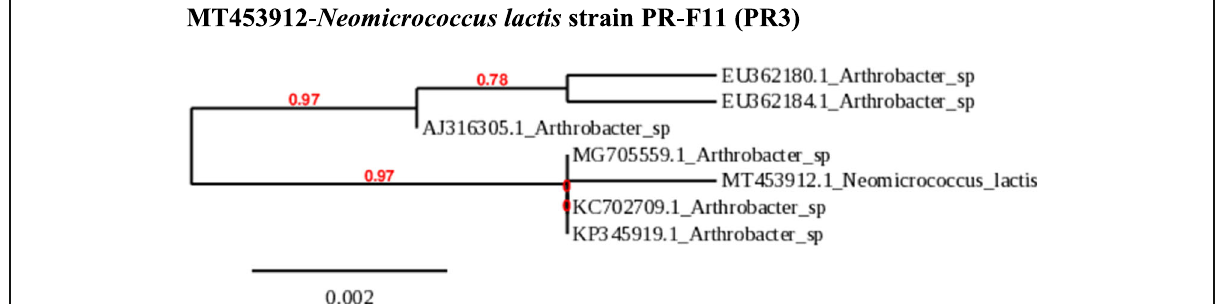
Fig. 3 Neighbor-joining tree showing the phylogenetic relationships of 16S rRNA gene sequences of N. lactis . The scale bar indicates evolutionary